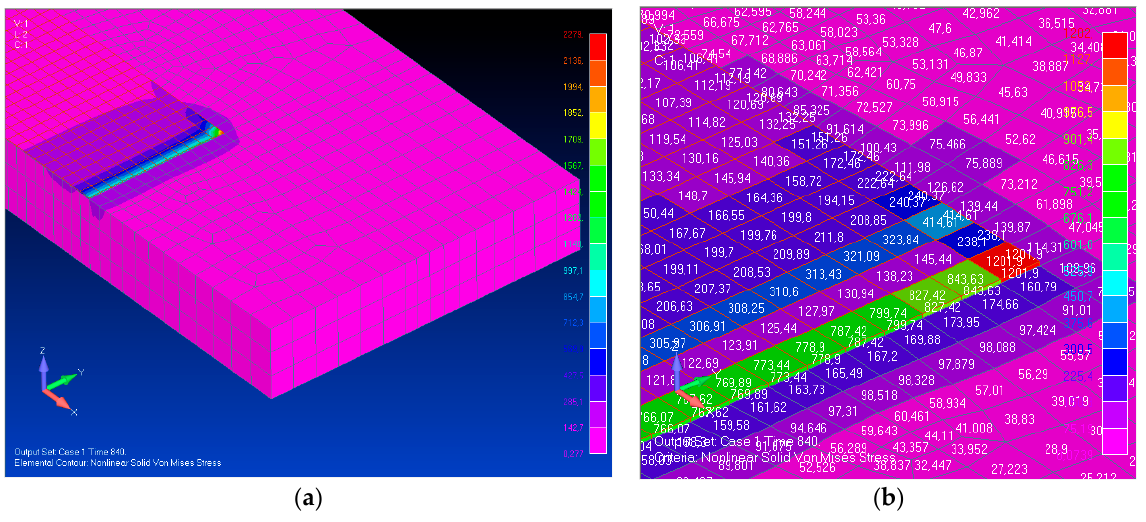
Figure 11. Stress distribution in the adhesive layer simulated by one row of finite elements before failure: ( a ) Mises stress isofield; ( b ) Mises stress values.